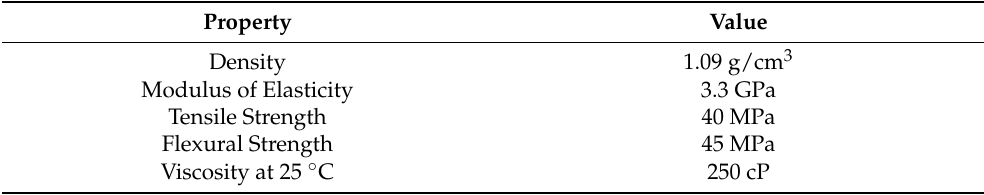
Table 1. The mechanical and physical characteristics of unsaturated polyester.